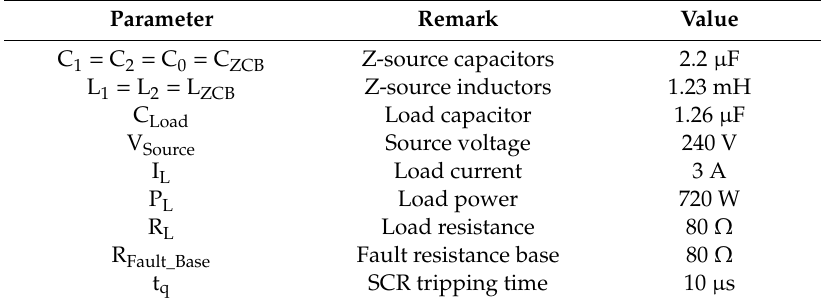
Table 1. Z-source circuit breaker (ZCB) parameter specification from preliminary design.